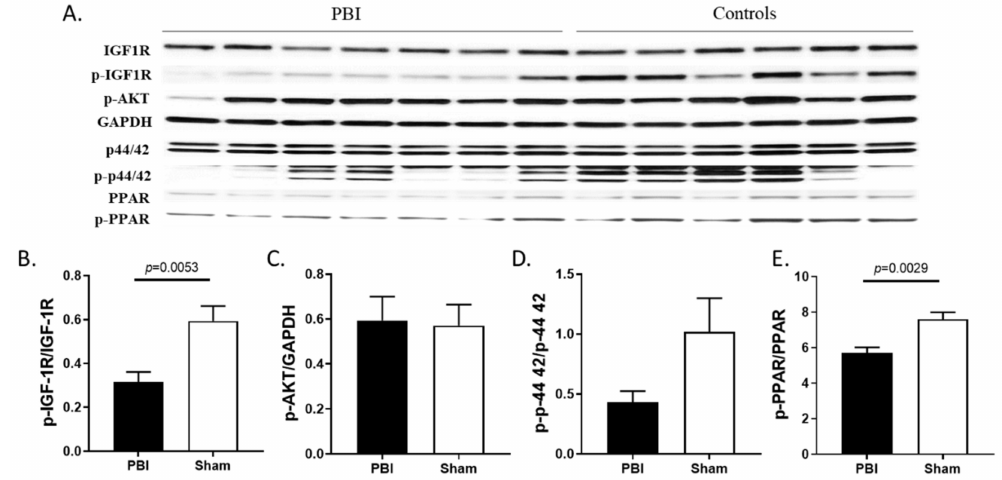
Figure 7. Western blot analysis of IGF-1 signaling pathway and PPAR activation in heart lysates of irradiated and control minipigs. ( A ) Evaluation of IGF-1R, Akt, p44/42 and PPAR phosphorylation in heart lysates of irradiated and control minipigs by SDS-PAGE and western blot. ( B – E ) Densitometric quantification was performed and values were normalized to respective loading control and presented as averages +/ −